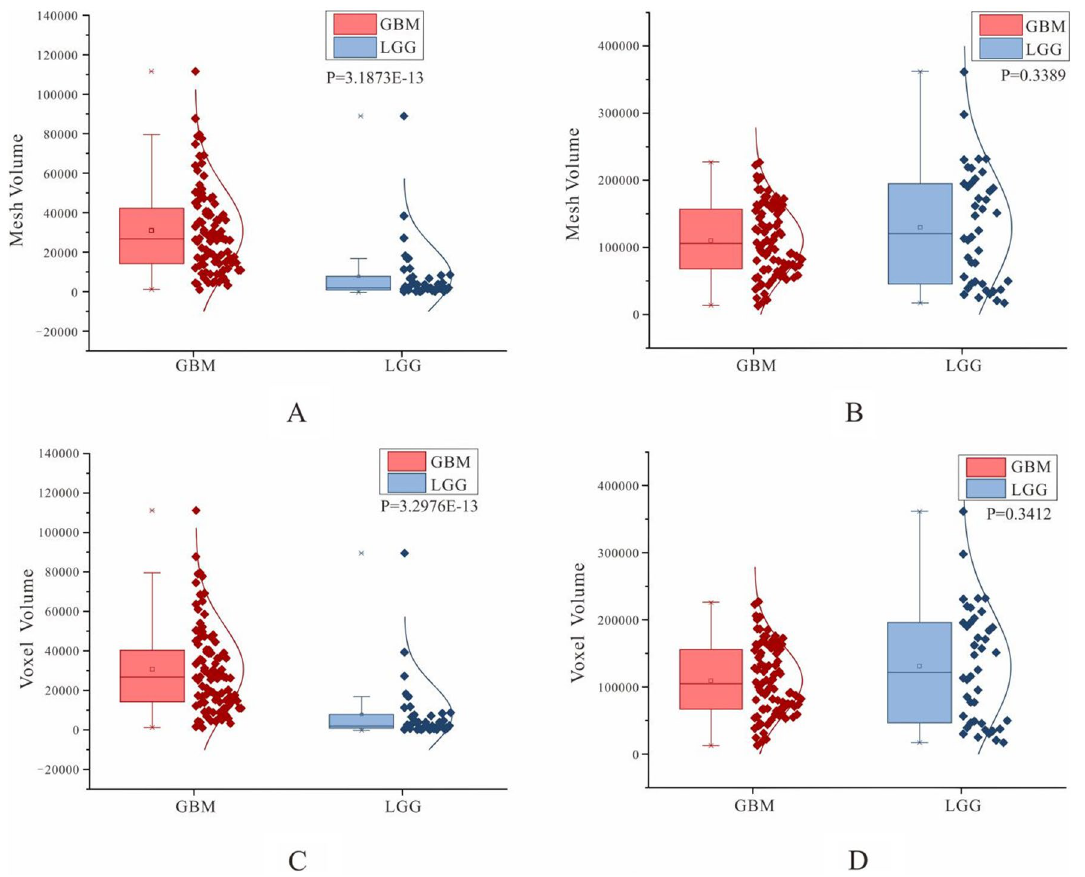
Fig. 4 Box plots for the two representative shape features in the ET subregion and whole tumor. a Mesh volume for the ET subregion. b Mesh volume for the whole tumor. c Voxel volume for the ET subregion. d Voxel volume for the whole tumor